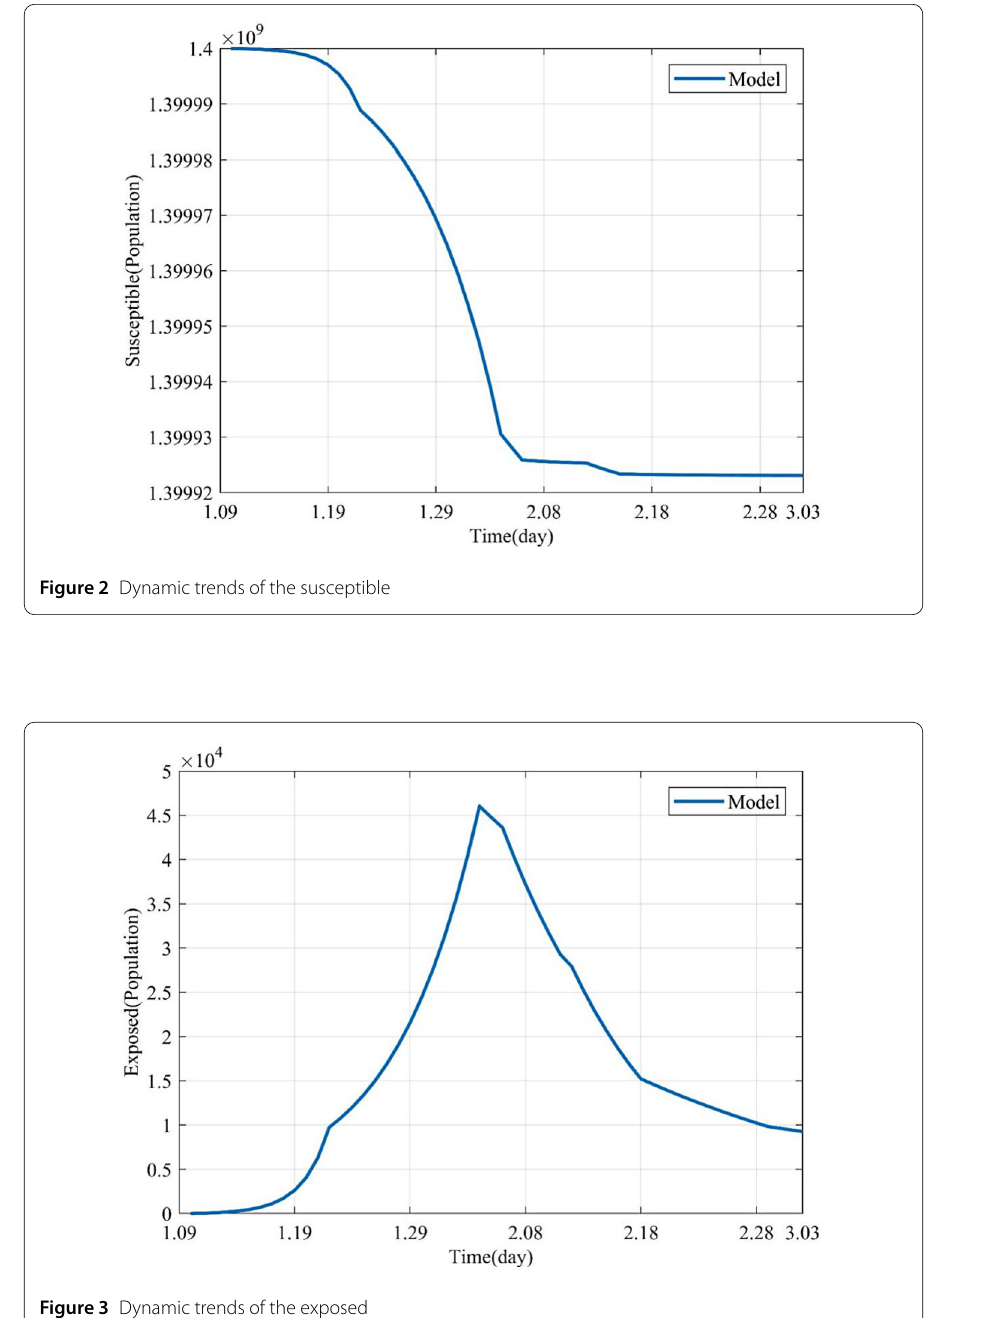
of the removed continued to increase which is consistent with the data issued by